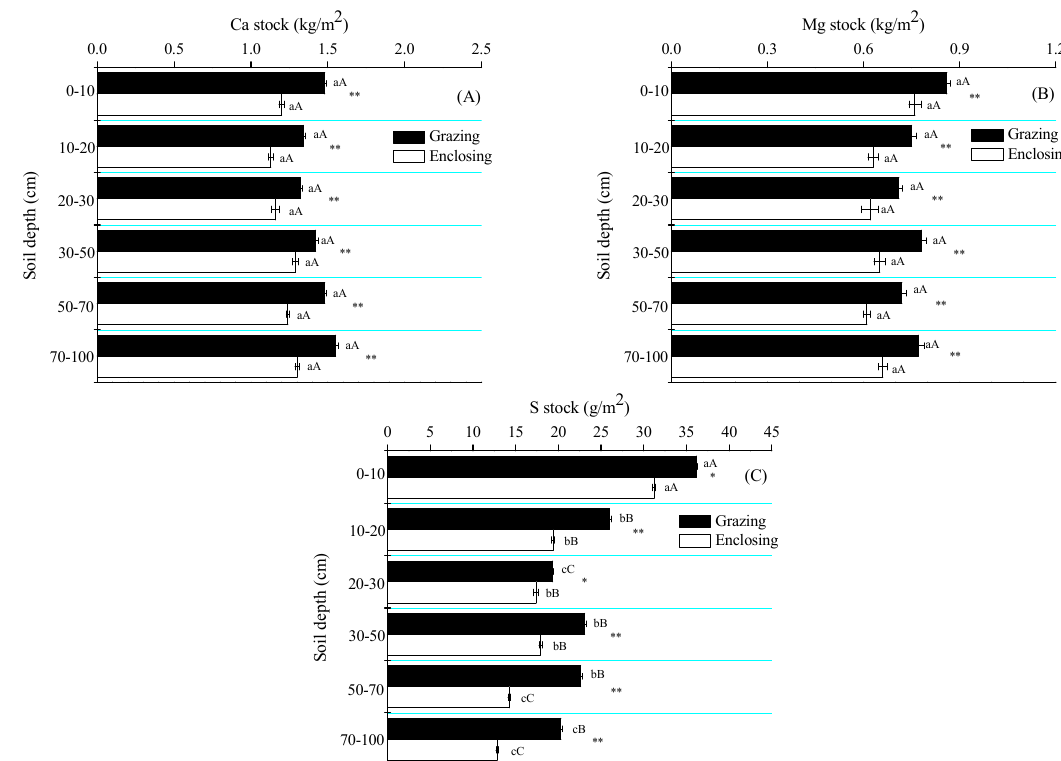
Figure 6. The soil Ca ( A ), Mg ( B ), and S ( C ) stocks of treatments. Note: * and ** show significant differences at p < 0.05 and p < 0.01 of Ca, Mg, and S stocks in each soil layer between two treatments, and NS shows no difference ( t -test). Lowercase and capital letters show differences at p < 0.05 and p < 0.01 of Ca, Mg, and S stocks among different soil layers at each treatment by ANOVA. Error bars are one standard deviation.